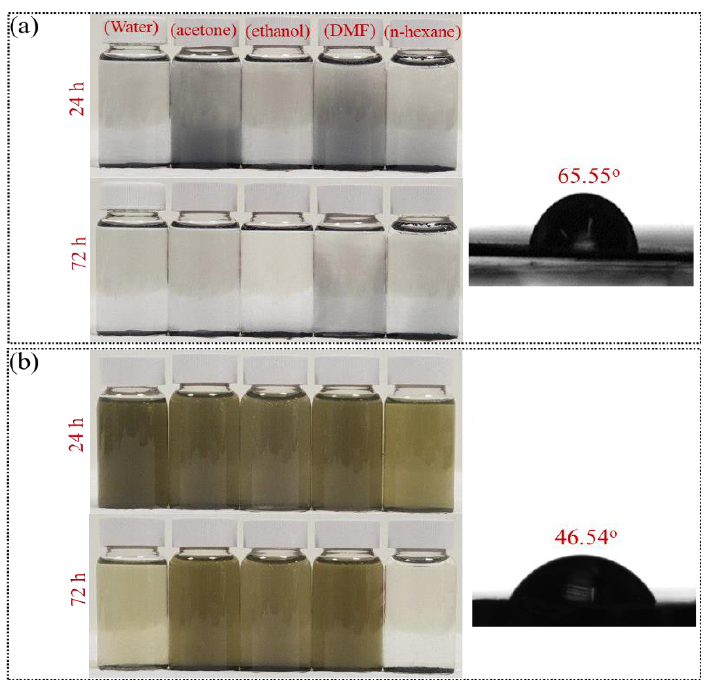
Figure 8. Dispersion/solubility profiles and water contact angle measurements for ( a ) ball-milled MoS 2 without functionalization and ( b ) F-MoS 2 nanosheets.